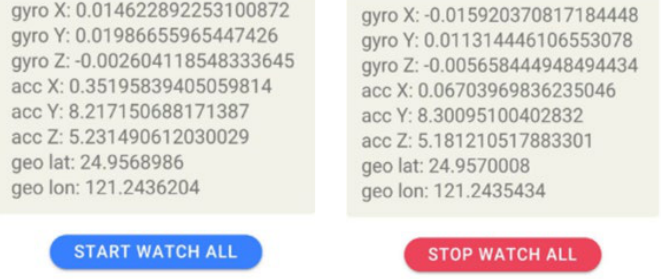
Figure 3. The Prototype System.